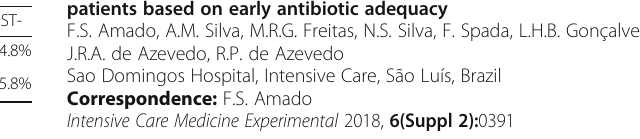
Table 2 (abstract 0389). Proportion of changed antibiotic prescriptions according to the availability of SC and AST